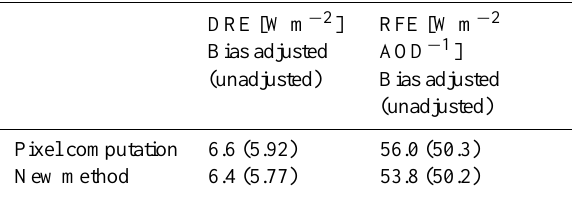
Table 2. Regional and seasonal mean values of instantaneous DRE and RFE based on the pixel-level computation and the new method.